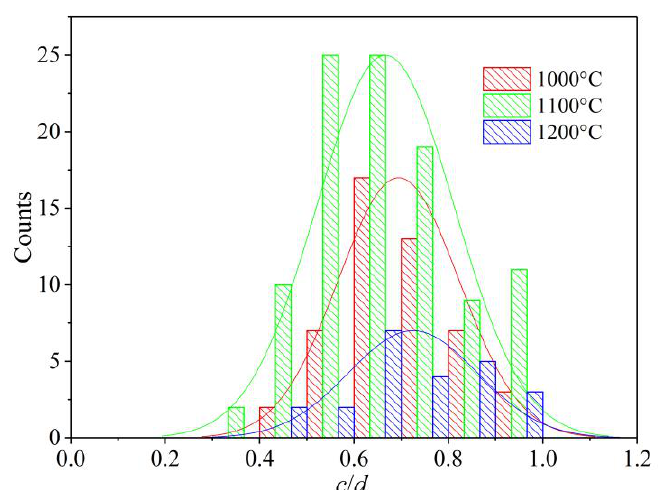
Figure 17. Column plots and Gaussian distribution curves showing the c / d ratios for the microstructures etched at 1000 °C (red curve), 1100 °C (green curve) and 1200 °C (blue curve).